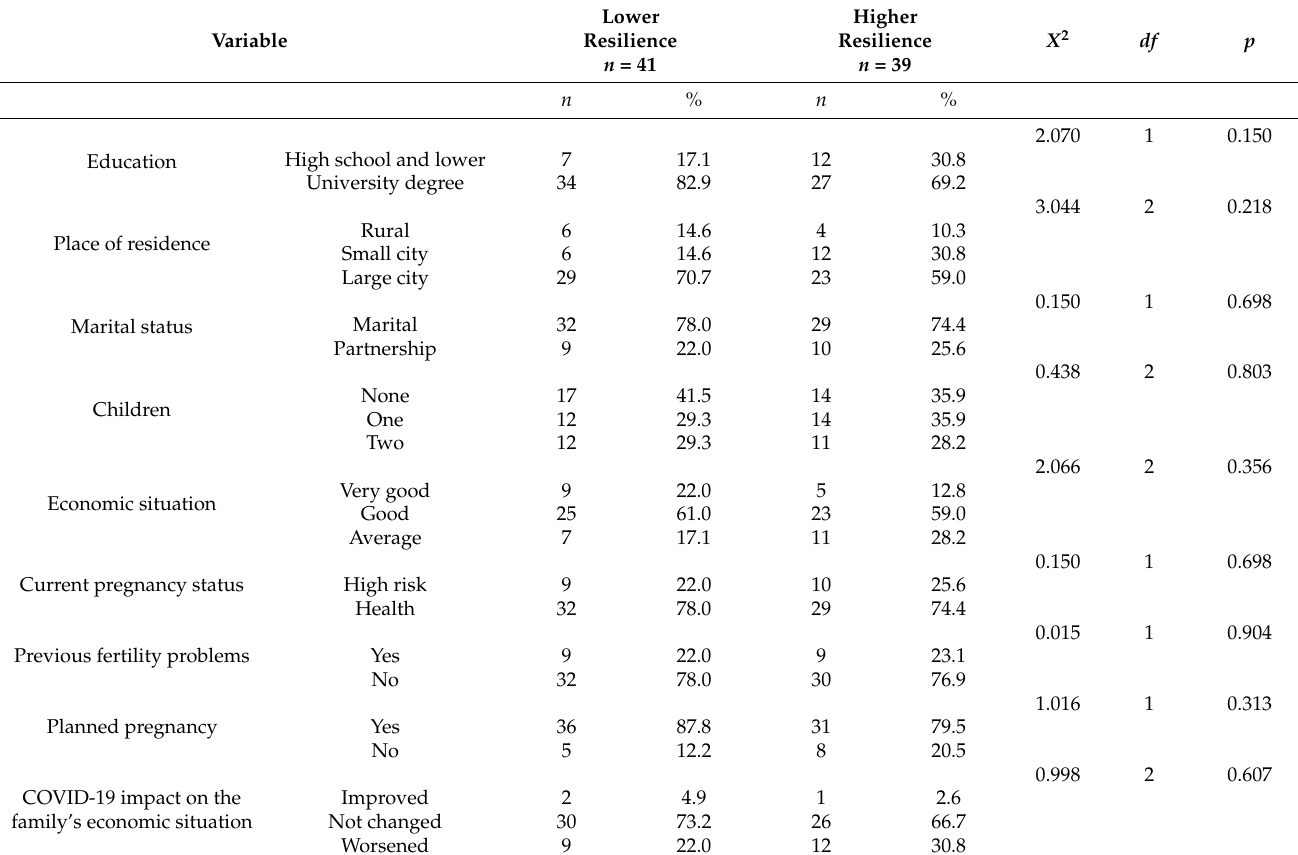
Table 2. Sociodemographic characteristics concerning lower and higher resilience